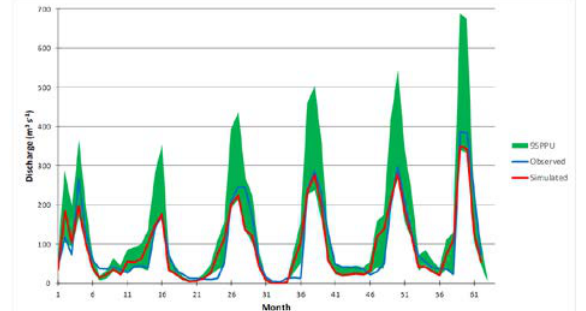
Figure 4: SWAT model calibration for flow 4/14/2010- 12/31/2015, Bumbuna reservoir